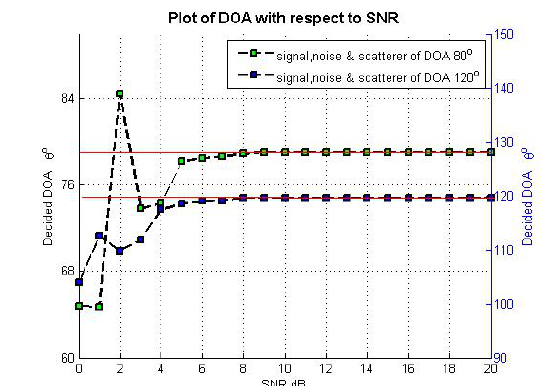
Figure 14: Plot of DOA with respect to SNR for case